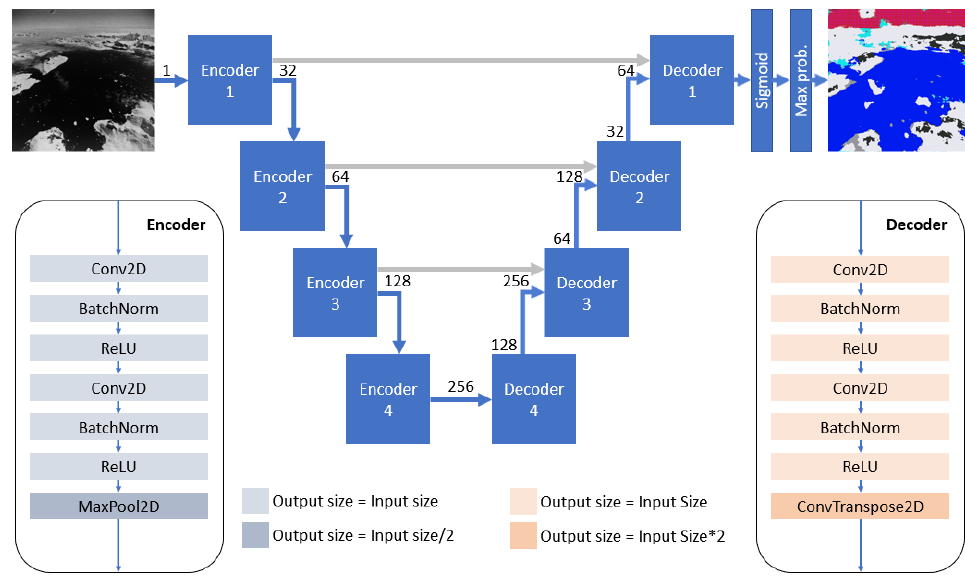
Figure 4. Structure of the U-Net